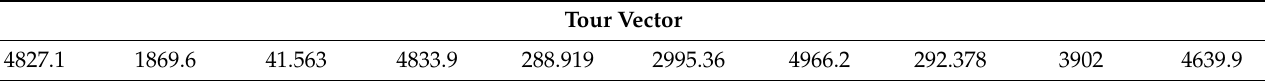
Table 2. Representation of a tour vector.